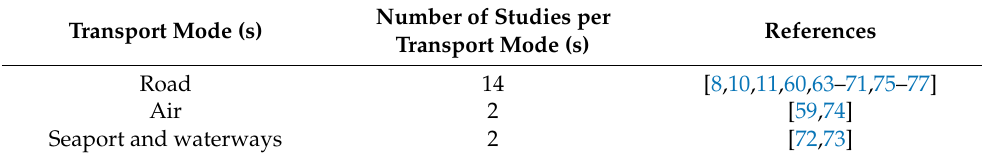
Table 8. Classification of COVID-19-related strategies studies based on transport mode.